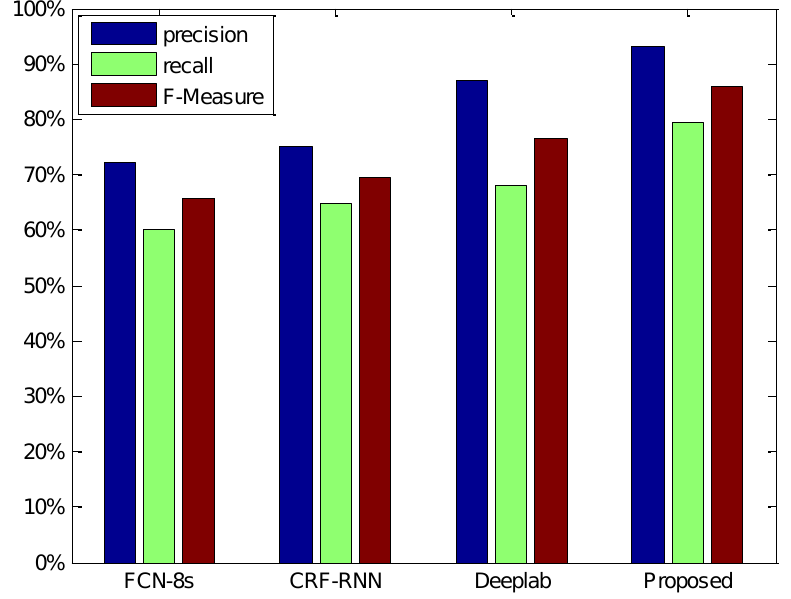
Figure 10. The precision, recall, and F-measure results of the four models.